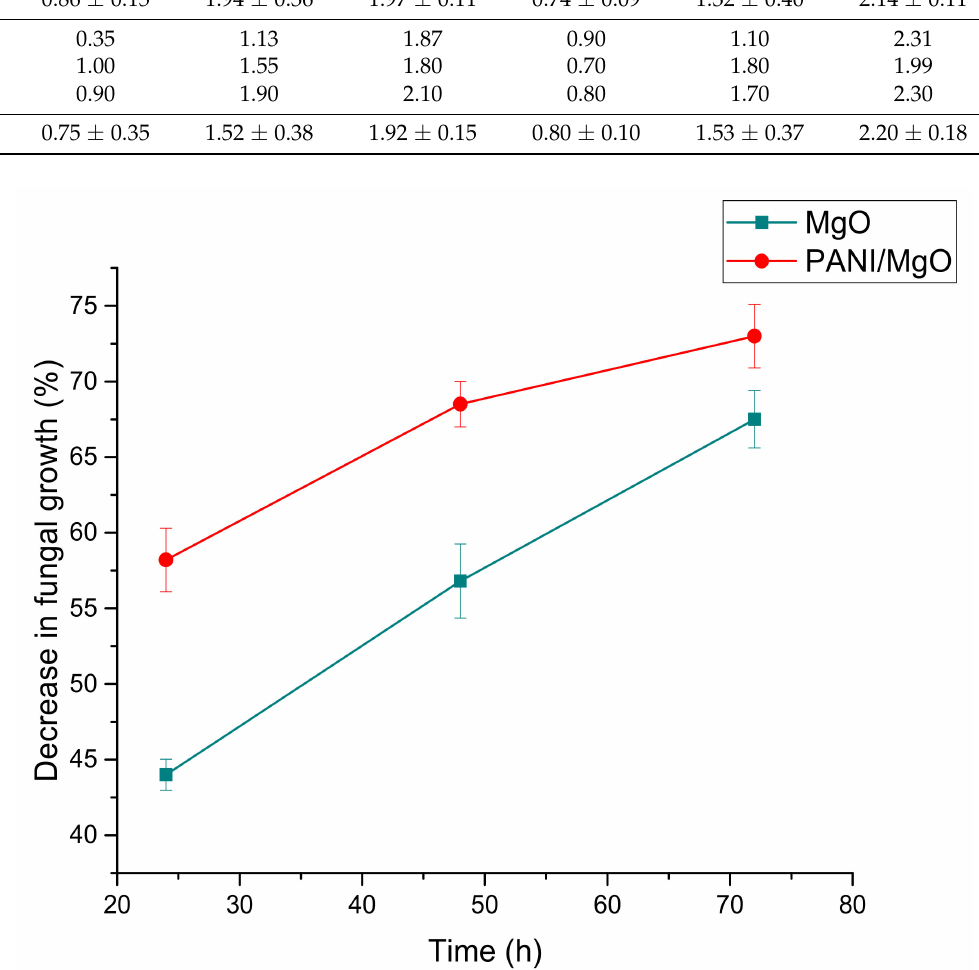
Figure 9. Comparison of the rates of decrease in fungal growth (%) by MgO and PANI/MgO nanoparticles at their 24 mM